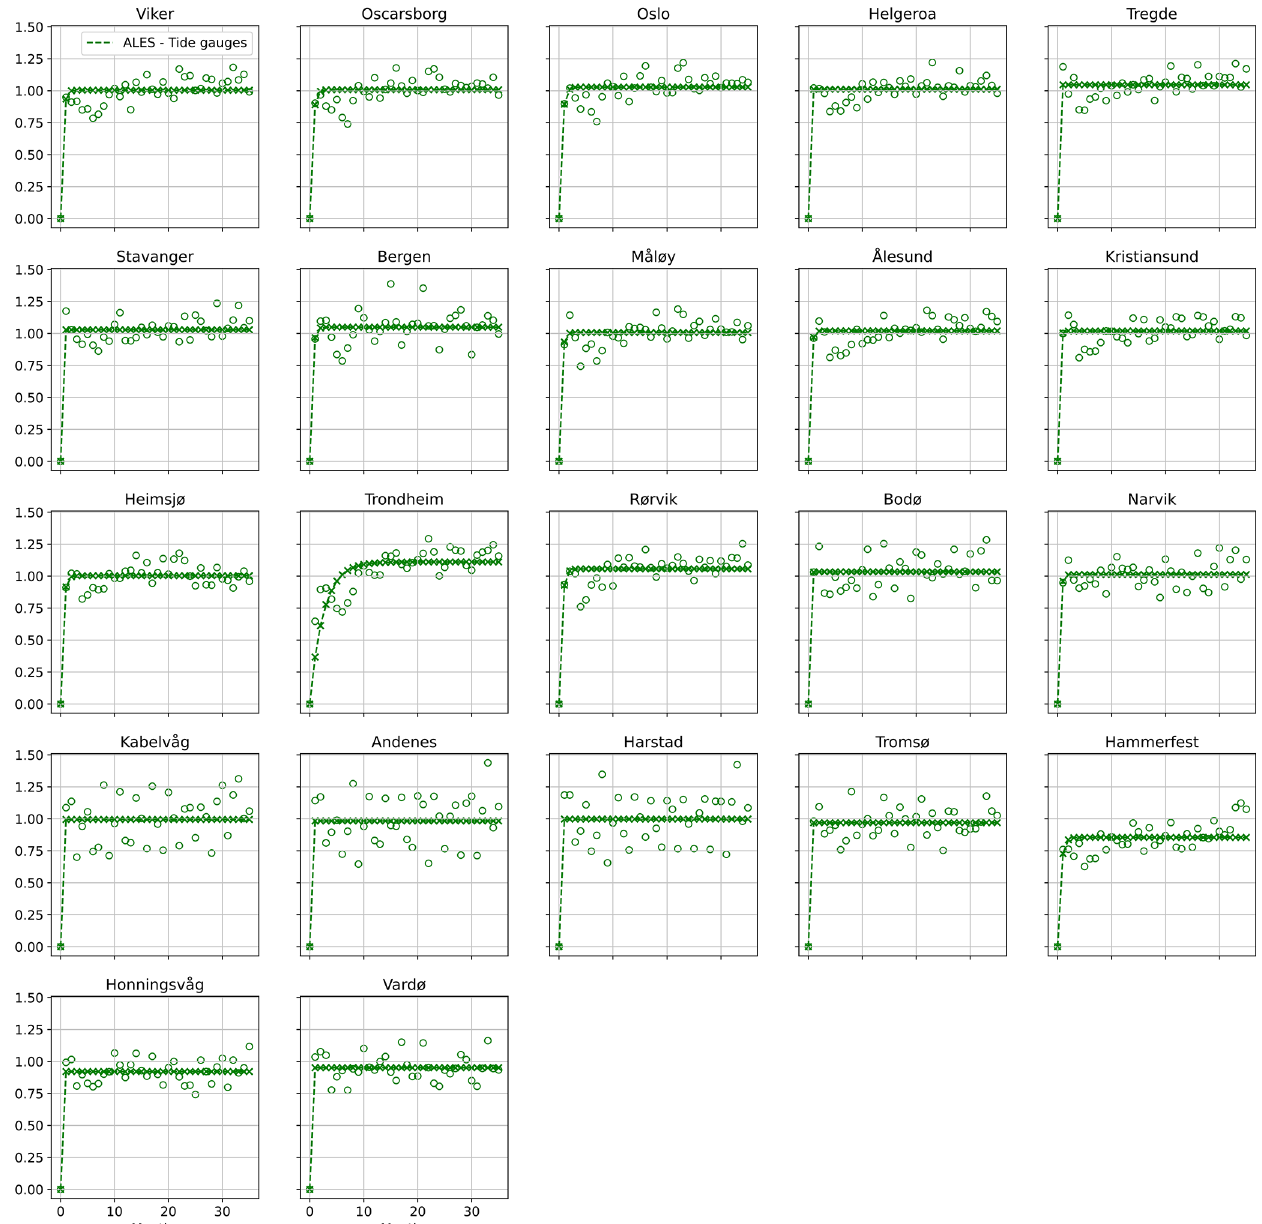
Figure A3. For each tide gauge along the Norwegian coast, semi-variogram of the difference between the detrended, deseasoned SLA estimated from the ALES-retracked satellite altimetry and from the tide gauge (empty circle) along with the corresponding fit (crosses connected by a dashed line). At each tide gauge location, we scaled each semi-variogram by the variance of the corresponding detrended and deseasoned SLA for all the plots to have the same limits on the y